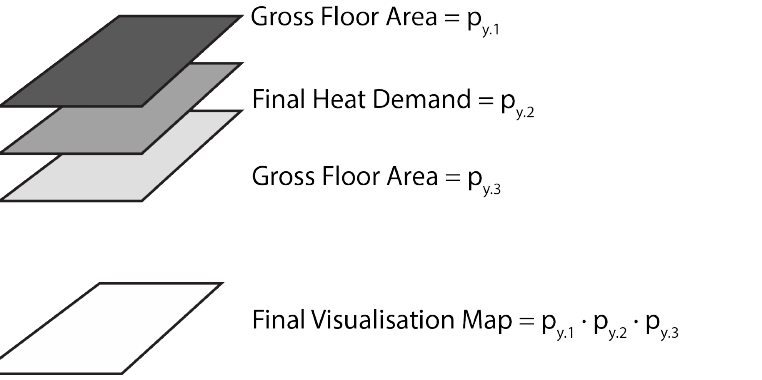
Figure A1. The process for blending the three original layers into the visualisation map. The subscript y indicates the band to which pixel